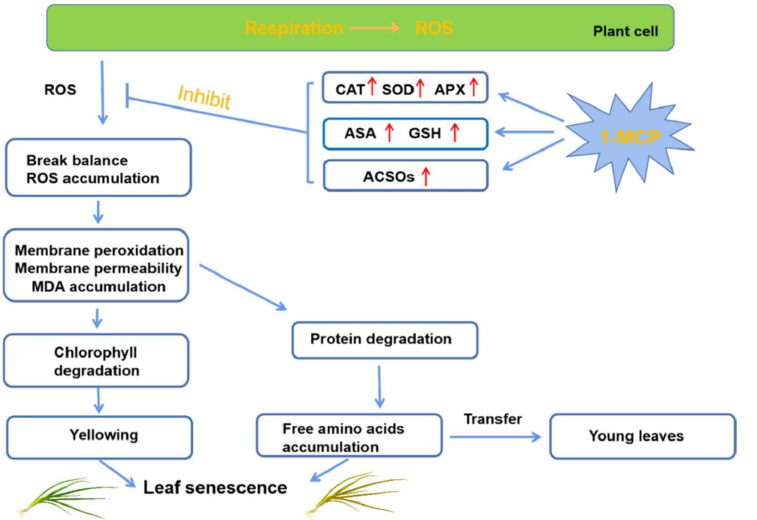
Figure 7. Possible senescence mechanism of chive leaves and possible mechanism of yellowing inhibition of chives during storage by 1-MCP